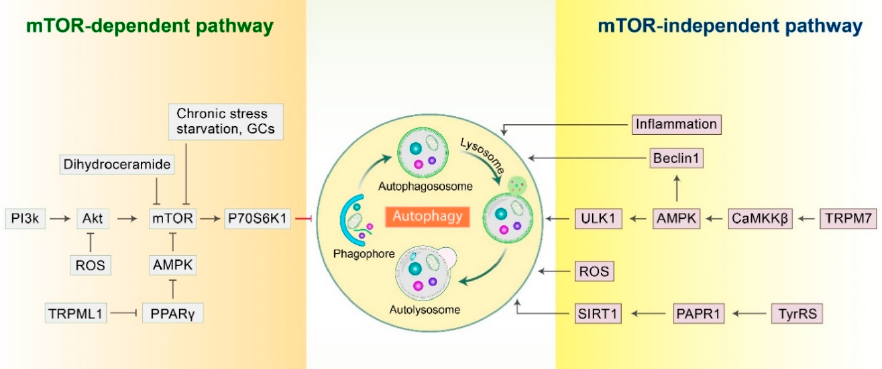
Figure 2. Autophagy regulation by the mTOR signaling pathway. Autophagy can be regulated by both mTOR-dependent as well as mTOR-independent pathways. mTOR phosphorylation can lead to ribosomal P70S6K1 phosphorylation, which is an mTOR substrate protein, thereby preventing autophagy initiation. Autophagy can additionally be stimulated by certain other elements for example starvation, chronic stress, as well as GCs through mTOR inhibition. Furthermore, TRPML1/PPAR γ /AMPK/mTOR and PI3K/Akt/mTOR are positive and negative autophagy regulators, respectively, and stimulation as well as prevention of these pathways may trigger autophagy. Also, dihydroceramide is a regulator of mTOR-mediated autophagy induction. However, ROS stimulates autophagy via mTOR-dependent (inhibit Akt) as well as mTOR-independent pathways directly activate autophagy. Besides, inflammatory stimulation of microglia plays a role in autophagy initiation. TRPM7, CaMKK β , AMPK as well as TyrRS, PARP1, and SIRT1 are the most important positive modulators in mTOR-independent autophagy